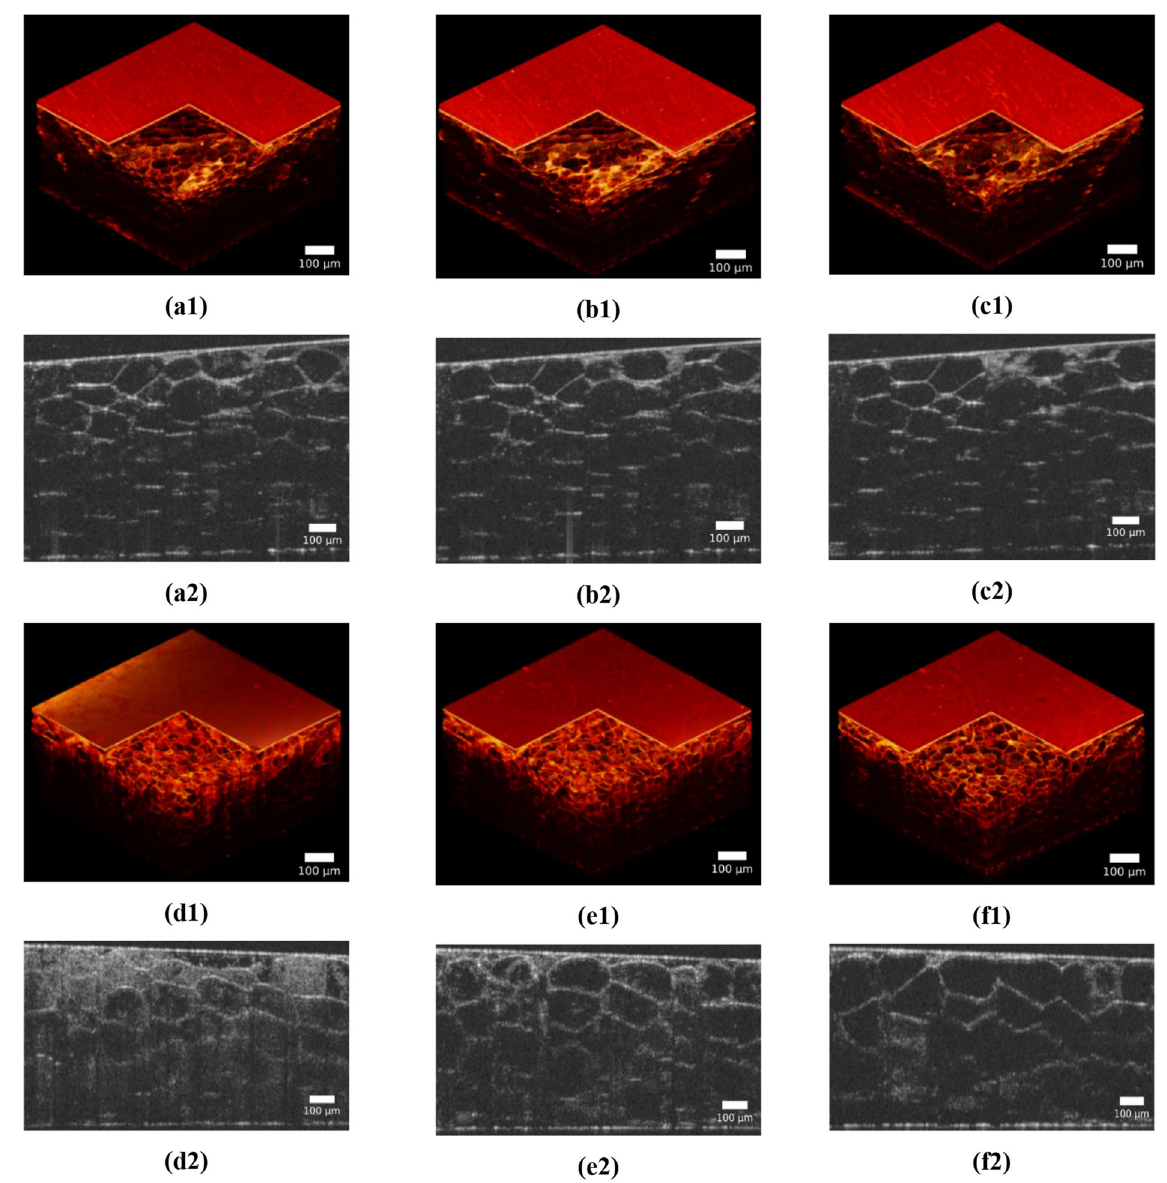
Figure 6. Ex vivo OCT images of human ( a – c ) and porcine ( d – f ) fat tissue slices for different temperatures: 23 °C ( a ); 30 °C ( b ); 38 °C ( c ); 25 °C ( d ); 30 °C ( e ); 38 °C ( f ). ( a1 )–( f1 ) typical 3D images; ( a2 )–( f2 ) typical